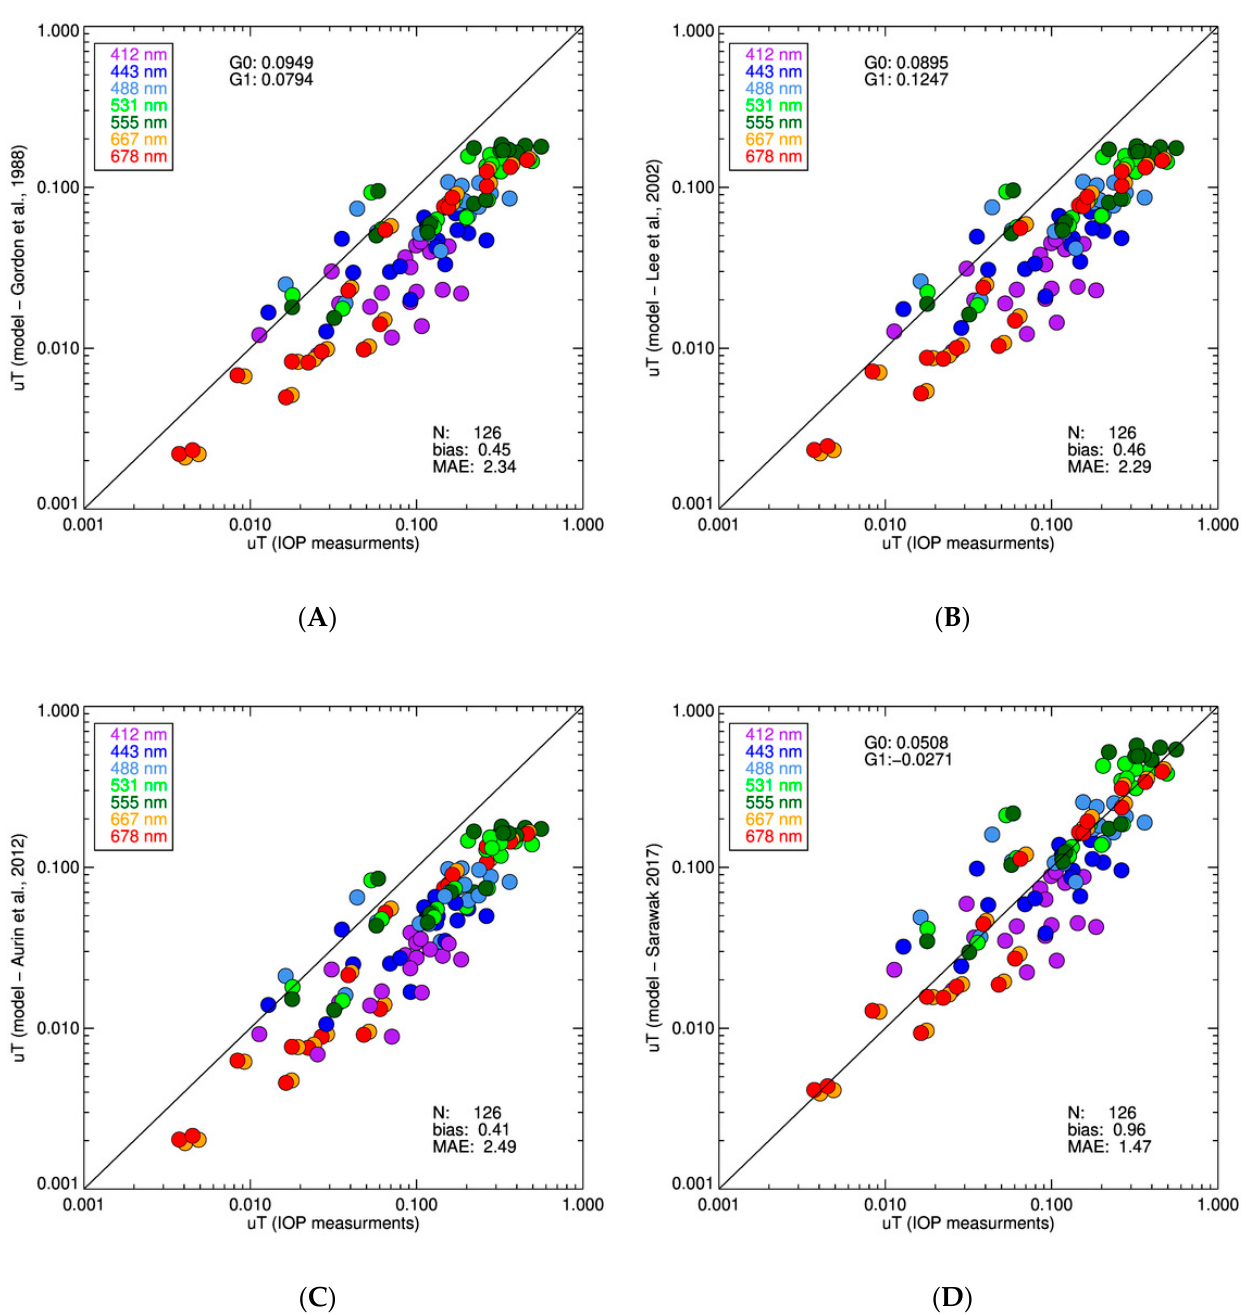
Figure 4. Conversion of underwater remote sensing reflectance to backscattering albedo. Comparison of in-situ measure- ments with model according to ( A ) Gordon et al., 1988, ( B ) Lee et al., 2002, ( C ) Aurin et al., 2002 using spectral f/Q values and ( D ) our Sarawak regional parametrisation.